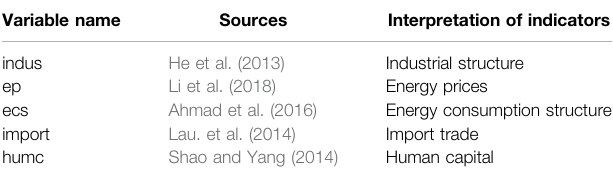
TABLE 1 | De fi nitions and sources of each technical inef fi ciency item. TABLE 2 | Estimated results of main effects of